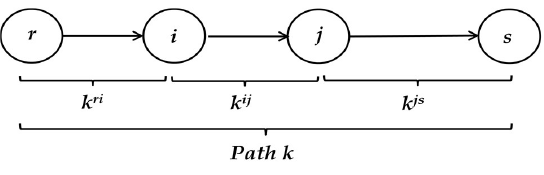
Figure 1. Description of the sub-path. 169